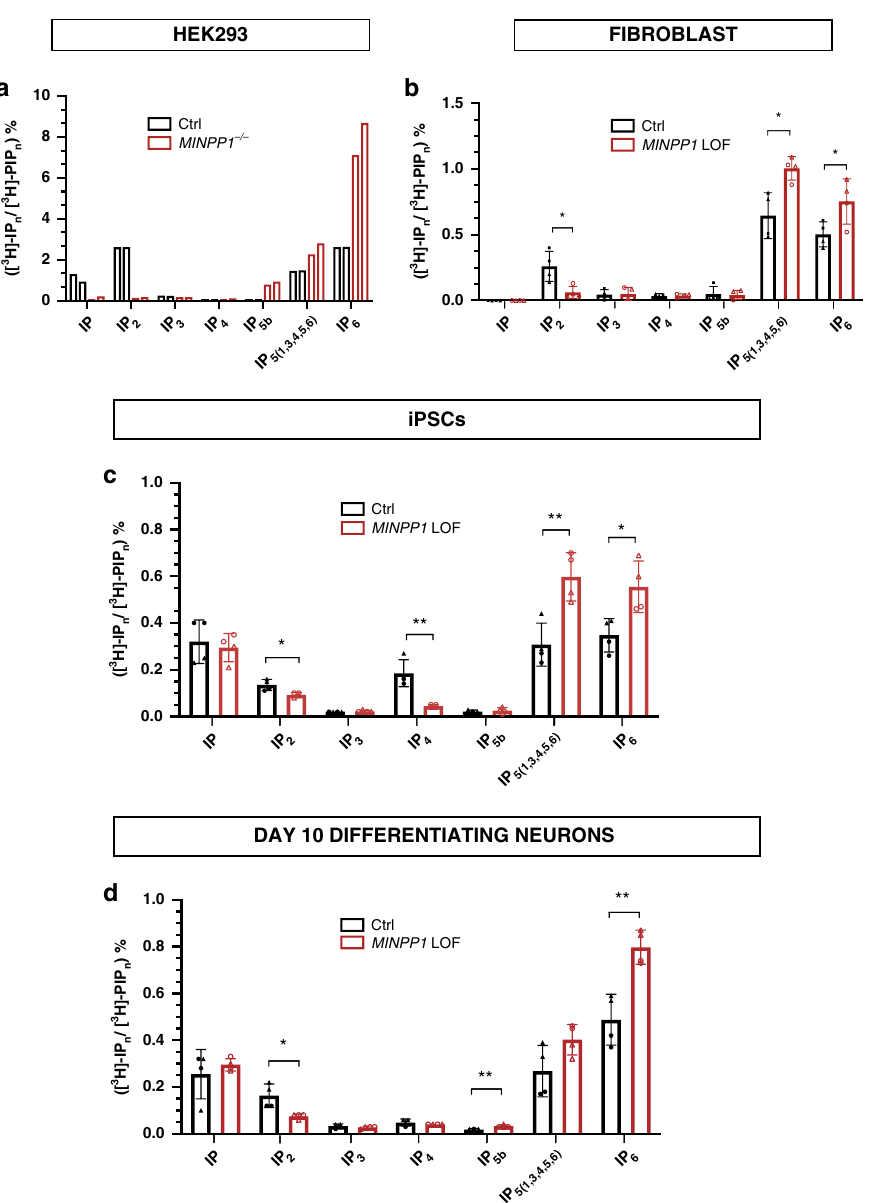
Fig. 4 MINPP1 absence leads to disruption in inositol phosphates metabolism. a – d SAX-HPLC analysis of inositol phosphate levels in MINPP1 − / − HEK293 cells ( a ), patient fi broblasts (CerID-30-1 and CerID-30-2) ( b ), MINPP1 LOF (patient-derived (CerID-30-2 (blank circle) and MINPP1 − / − (blank triangle)) iPSCs ( c ), and their day-10 differentiating neuron counterparts ( d ). The peaks ([ 3 H]-IP n ) were identi fi ed based on comparison to standards. [ 3 H]-IP n levels are presented as percentage of total radioactivity in the inositol-lipid fraction ([ 3 H]-PIP n ). All error bars represent standard deviation (s.d.). (For ( a ), n = 2 and both experiments are represented. For ( b – d ), n = 4, two-tailed student ’ s t -test, * p ≤ 0.05 and ** p ≤ 0.01). IP n , inositol phosphates; PIP n , phosphatidylinositol phosphates. Source data are provided as a source data fi